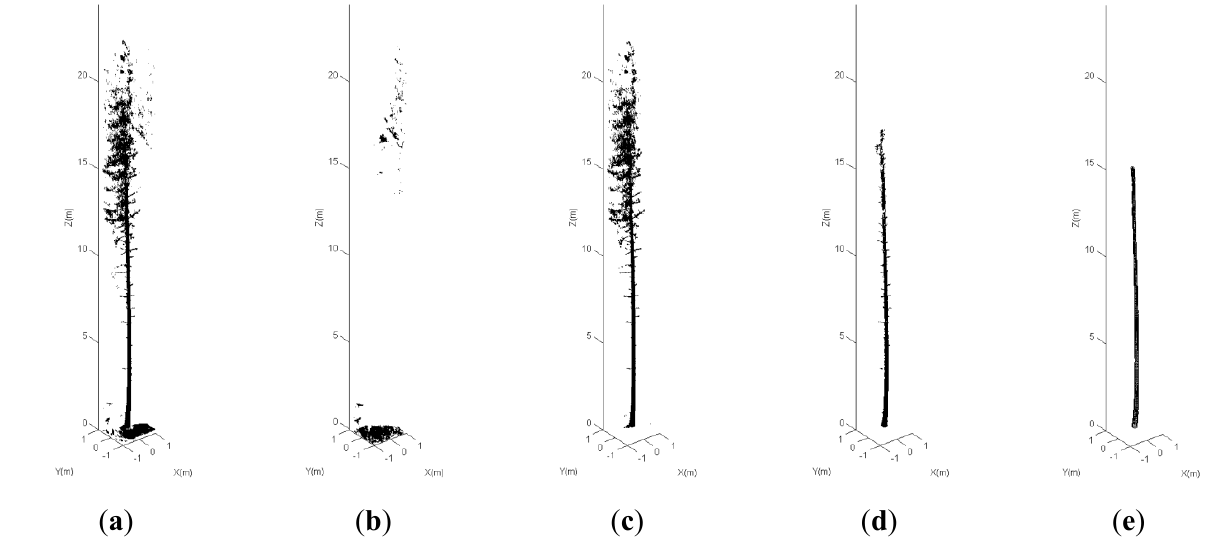
Figure 3. The steps in stem change detection: ( a ) the point cloud for a tree before the change; ( b ) the point cloud in the space corresponding to (a) after the change; ( c ) the differences found in the data-orientated analysis; ( d ) the detected stem points; ( e ) the reconstructed stem